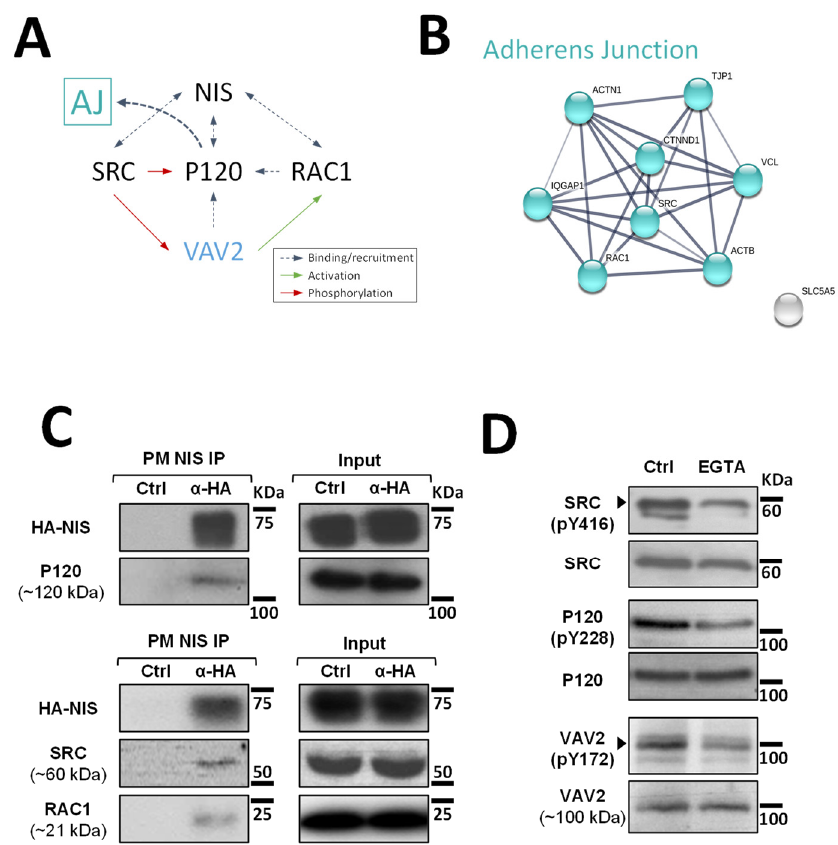
Figure 3. Validation of high-confidence NIS interactions detected by MS analysis. ( A ) Diagram depicting the functional interplay reported in the literature for SRC, RAC1, P120 and VAV2 at adherens junction (AJ) complexes. ( B ) STRING-generated subnetwork with the AJ-associated NIS- PM candidate interactors, detected in our proteomic analysis. The network nodes represent the identified proteins. The grey lines connecting two nodes represent protein associations extrapolated from textmining-, experimental- and database-collected evidence. The thickness of the lines is proportional to the degree of confidence for the predicted association between the nodes. ( C ) NIS-PM immunoprecipitated protein complexes were analyzed by WB, using specific primary antibodies to detect the indicated target candidate proteins. The total (input) and immunoprecipitated (IP) HA-NIS levels were detected using a mouse anti-HA primary antibody to confirm the immunoprecipitation efficiency. ( D ) Impact of EGTA-mediated AJs displacement on SRC, P120 and VAV2 activation status was assessed in HA-NIS-TPC1 cells treated with either vehicle or EGTA (4 mM for 30 min) by monitoring SRC, P120 and VAV2 phosphorylation levels by WB. The uncropped bolts are shown in Supplementary Materials File S1.